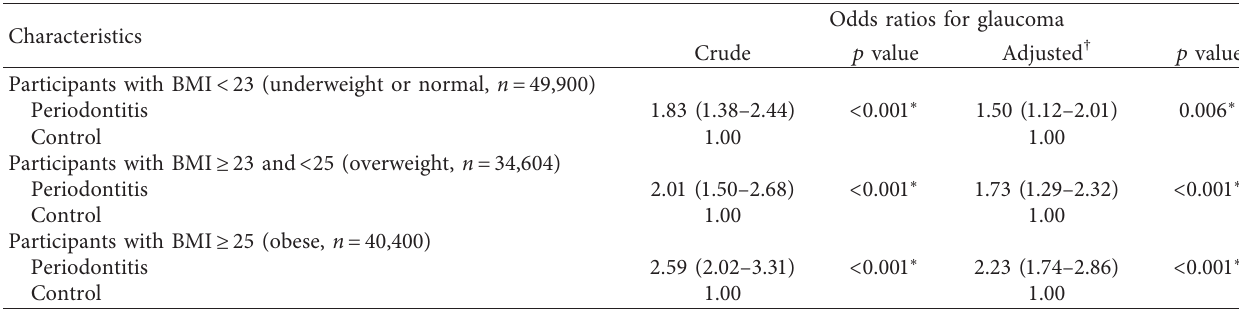
Table 4: Crude and adjusted odds ratios (95% confidence interval) of periodontitis for glaucoma according to body mass index.